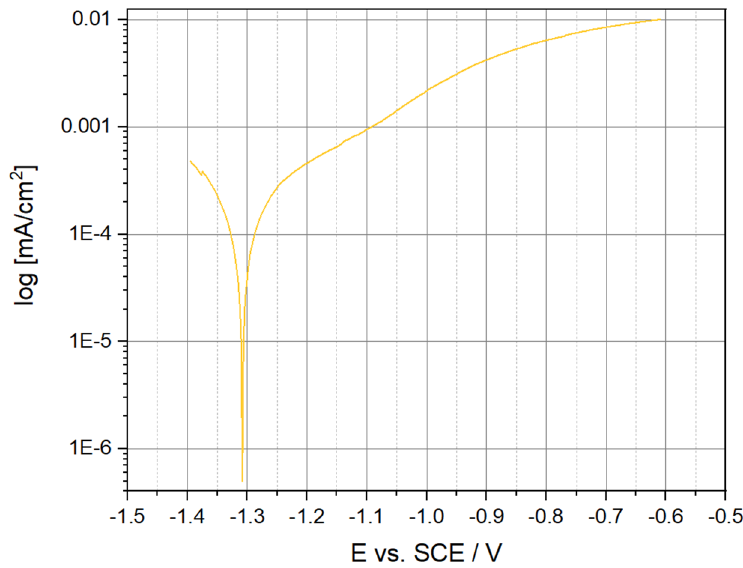
Figure 12. Polarization curve for the Mg–Zn–Ca–Au sintered alloy.